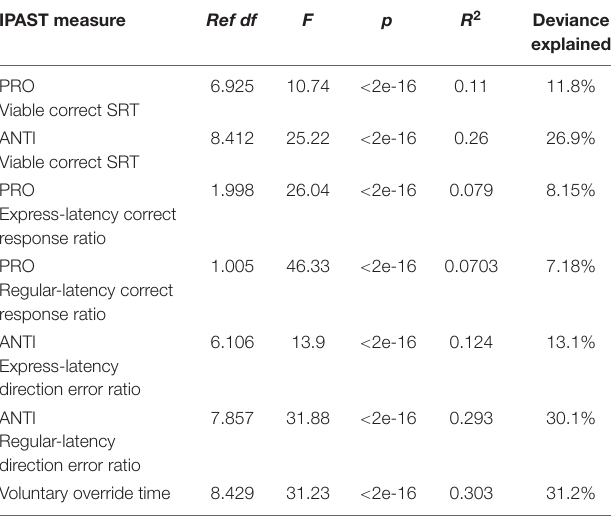
TABLE 1 | GAM fit